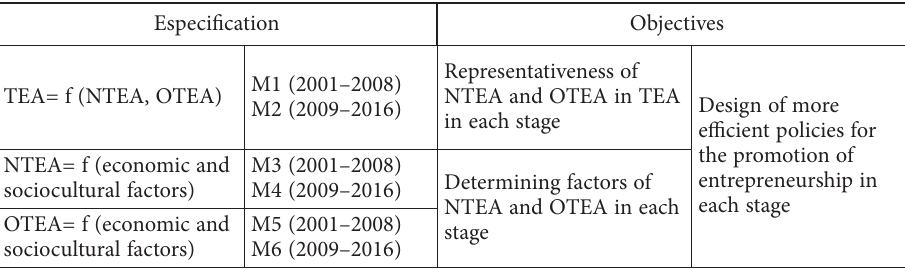
Table 3. Specification and objectives of empirical research